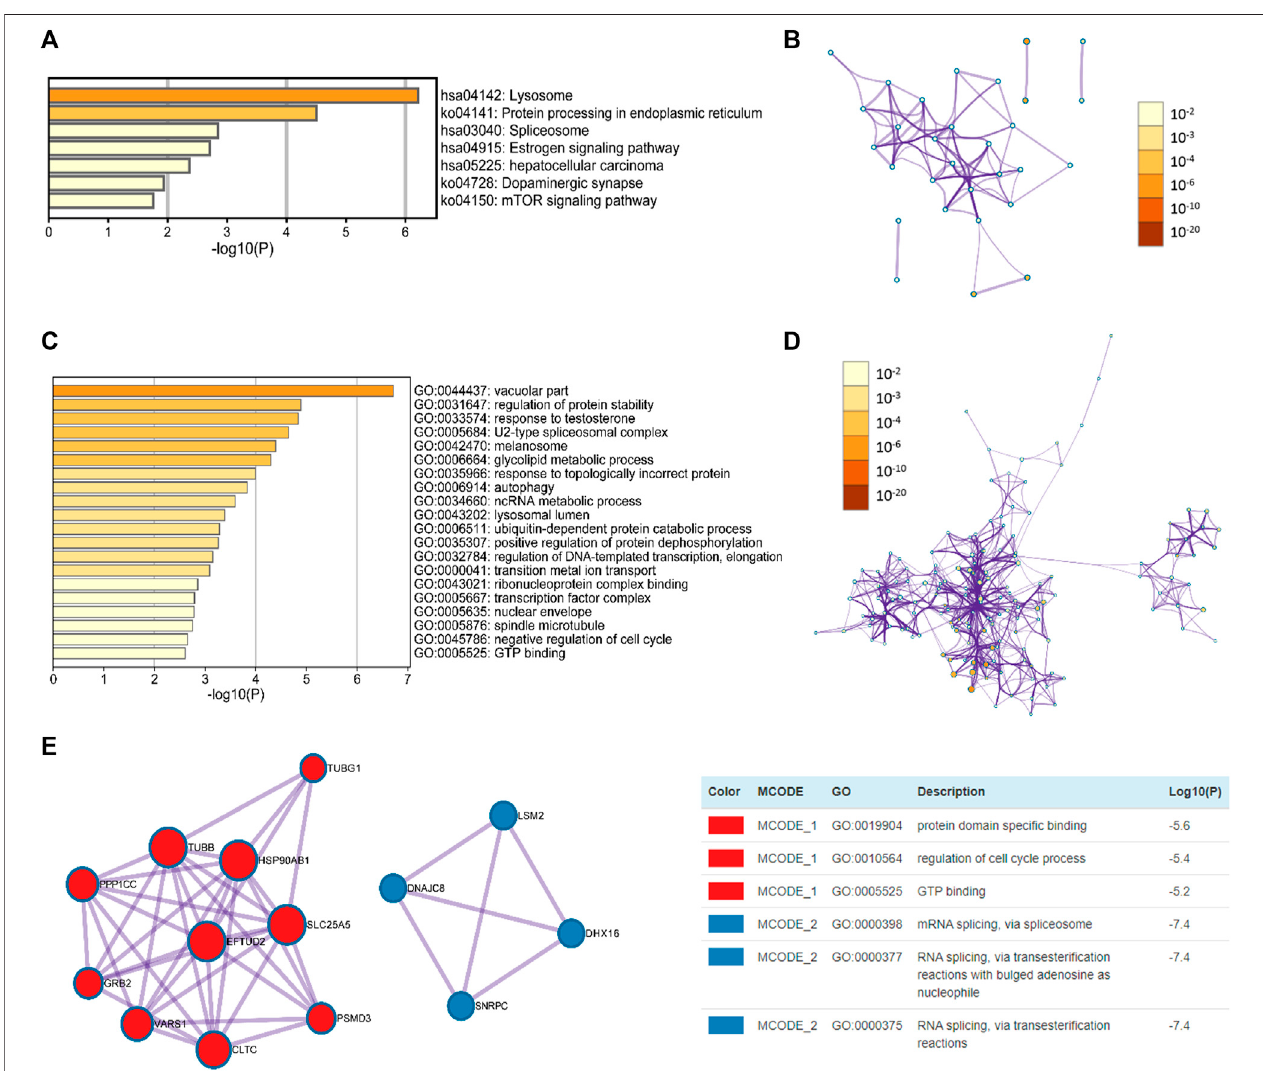
FIGURE8| EnrichmentanalysisofNEU1andsimilargenesinHCCpatients(GEPIAandMetascape) (A) TheheatmapofGOterms (B) ThenetworkofGOterms (C) The heatmap of KEGG terms (D) The network of KEGG terms (E) Two key MCODE components form the protein-protein interaction (PPI) network and independent functional enrichment analysis of MCODE